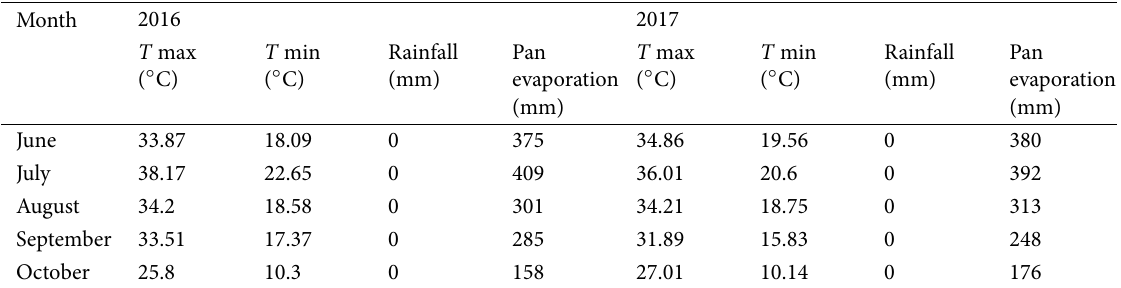
Table 1 Monthly mean, minimum, and maximum air temperatures; total rainfall; and evaporation during the growing